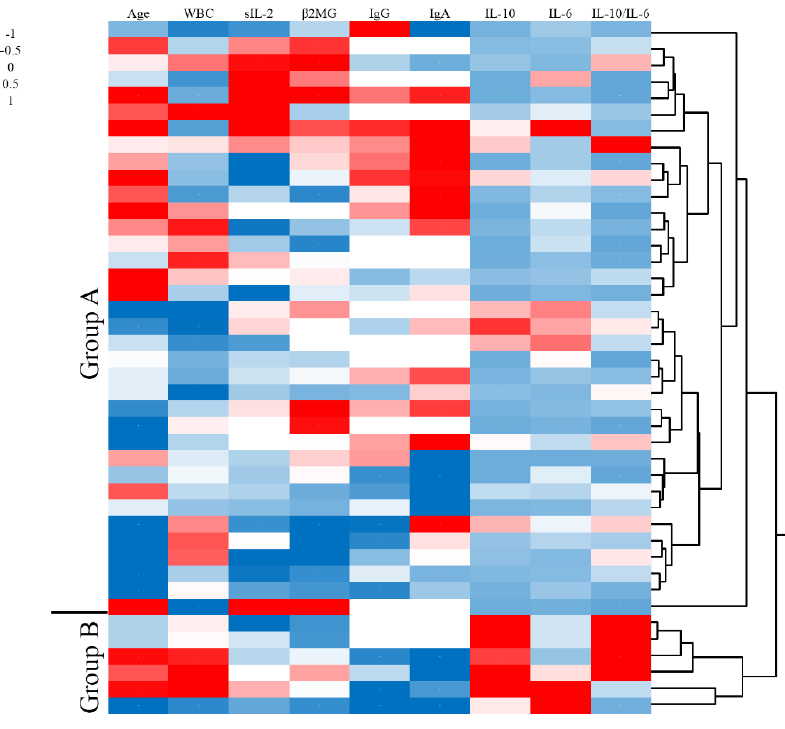
Figure 1. The patients were clustered into two groups by clustering analysis using clinical findings including age, peripheral blood tests and cytokines in vitreous